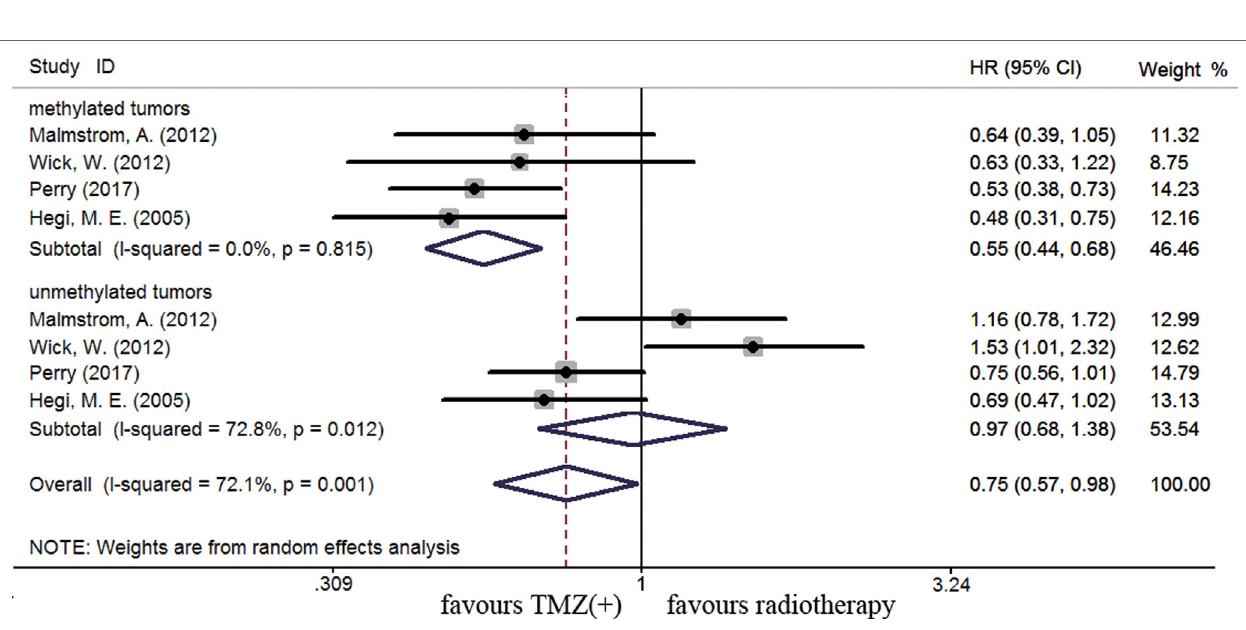
FiGURe 7 | Calculated HRs and 95% CIs for the relationship between methylation and OS benefit in elderly GBM patients (TMZ-containing therapy vs. radiotherapy alone).